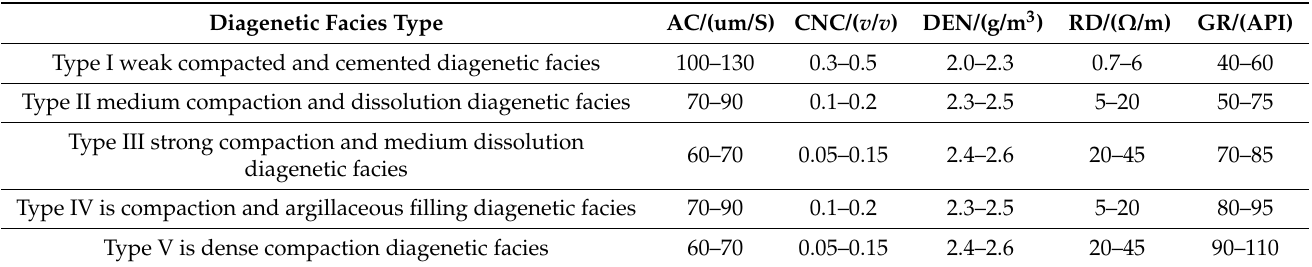
Table 2. Typical logging curves of reservoir diagenetic